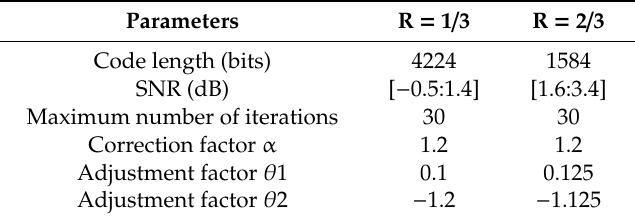
Table 2. Simulation parameters.